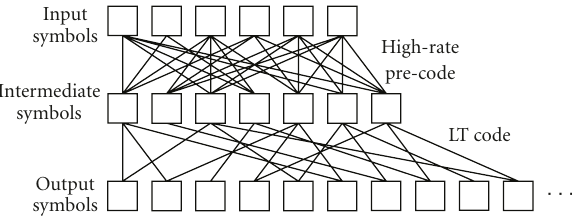
Figure 10: Representation of Raptor